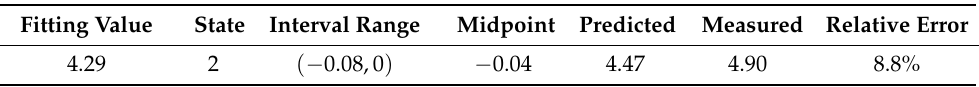
Table 11. Quantitative prediction of the sea clutter power of the latter position by the grey Markov model.